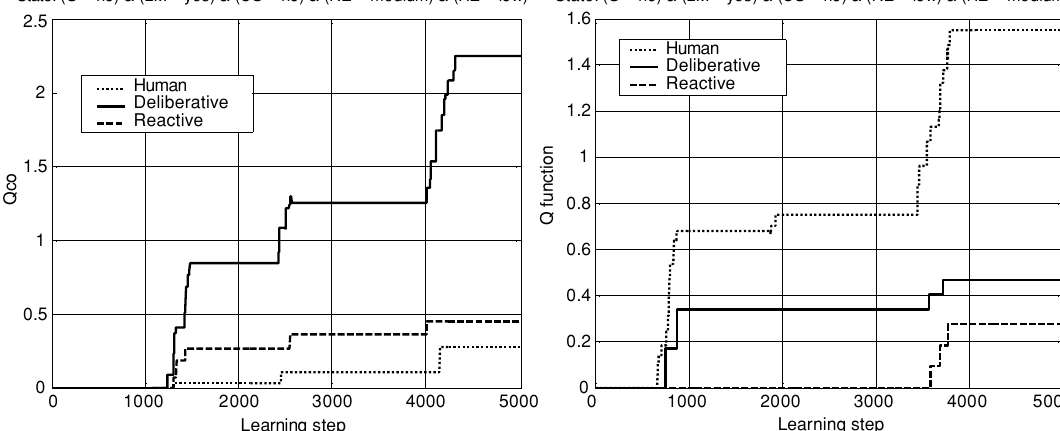
Figure 7 Q -function values for two selected states. The selected best actions are DELIBERATIVE and HUMAN actions,